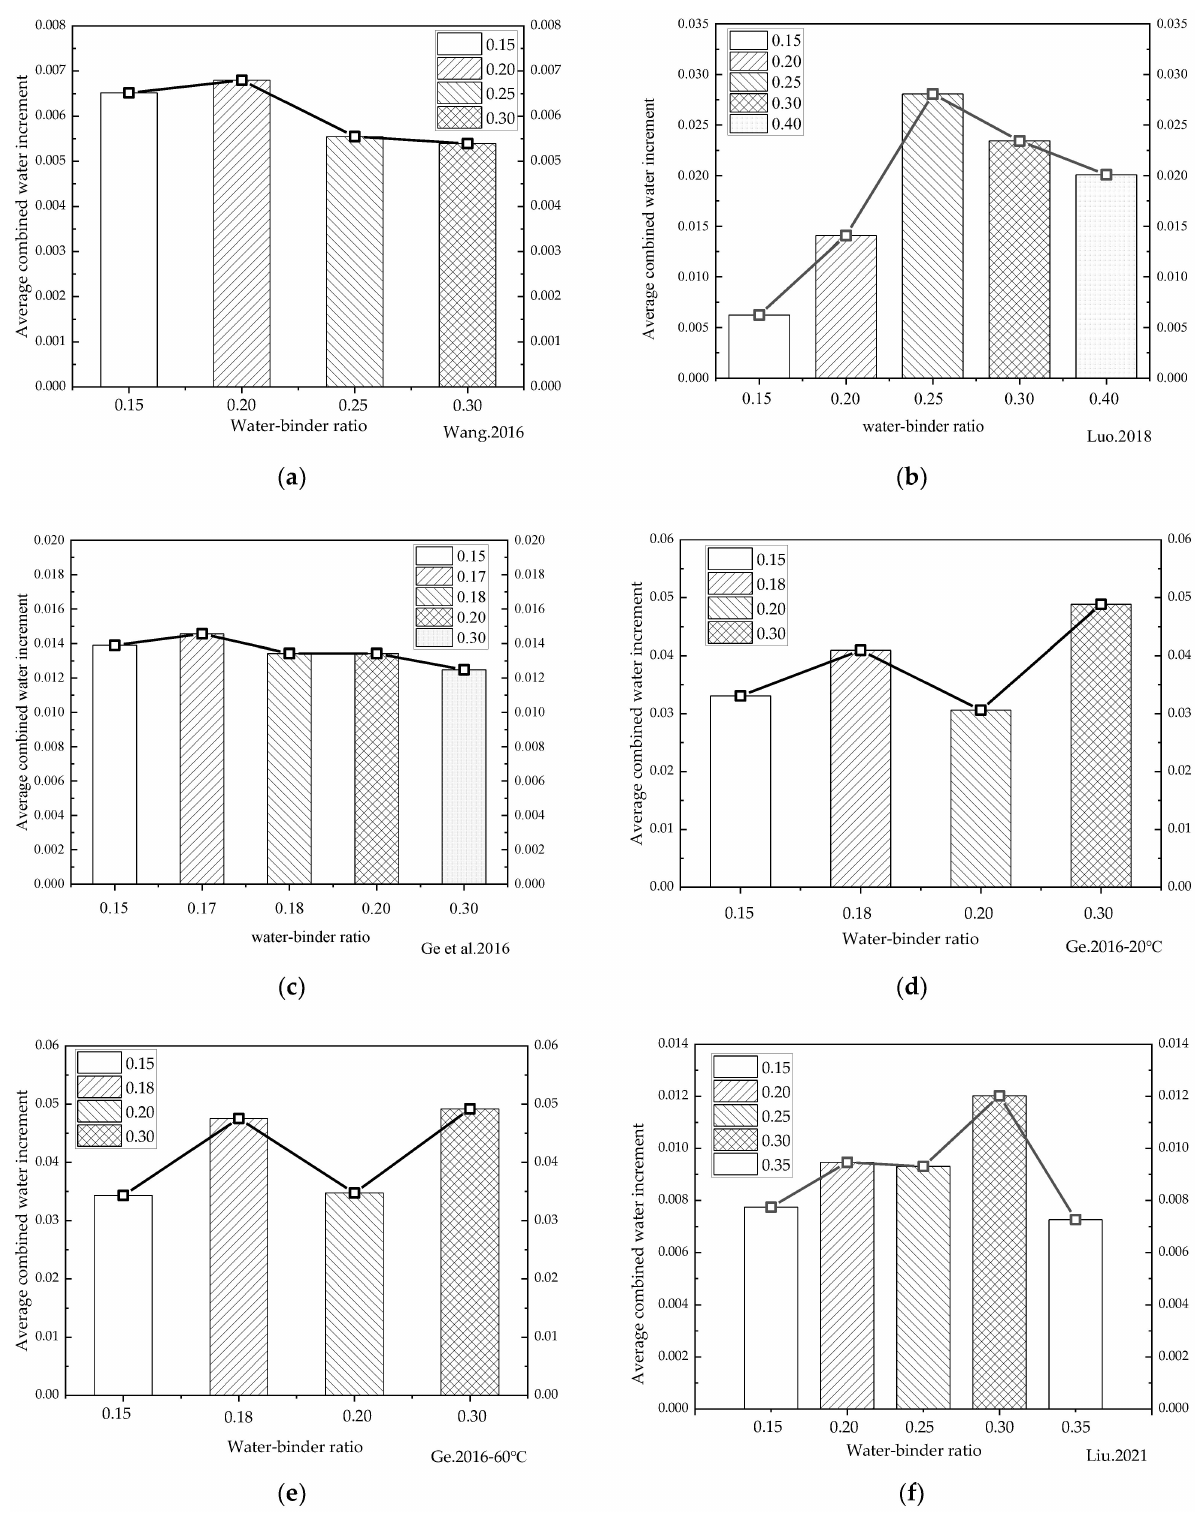
Figure 8. Variations in the average daily increment in combined water under different water/binder ratios. ( a ) [6] 180d average daily increment in combined water; ( b ) [40] 360d average daily increment in combined water; ( c ) [45] 90d average daily increment in combined water; ( d ) [60] 20 ◦ C-90d average daily increment in combined water; ( e ) [60] 60 ◦ C-90d average daily increment in combined water; ( f ) [61] 360d average daily increment in combined